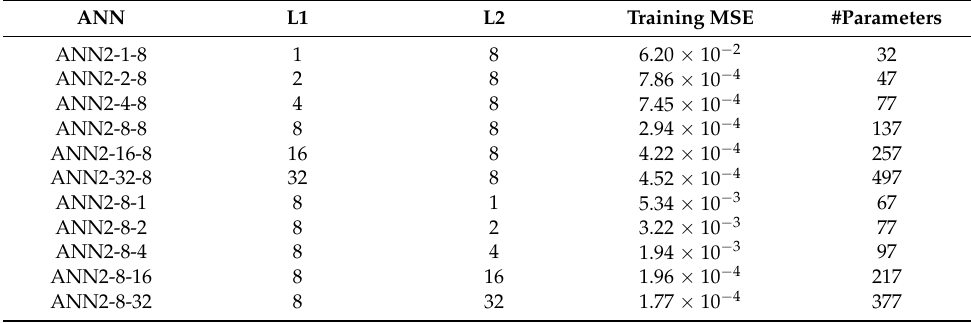
Table A4. Two-hidden-layer ANN training results